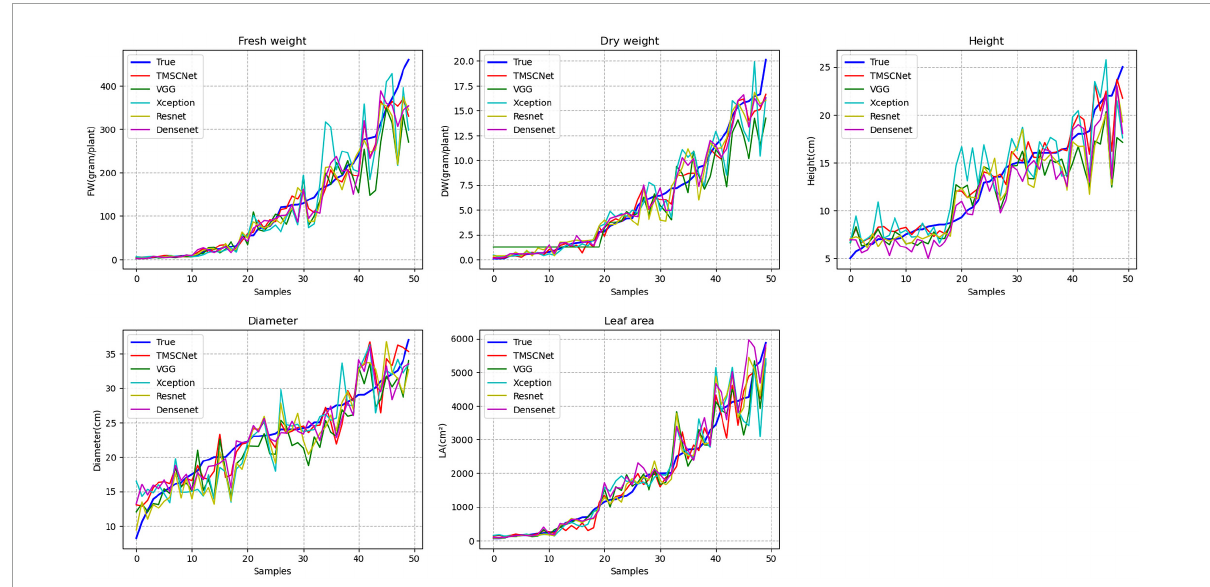
FIGURE9 Comparison curve of evaluation results based on different classical convolutional neural networks (CNNs) and TMSCNet.